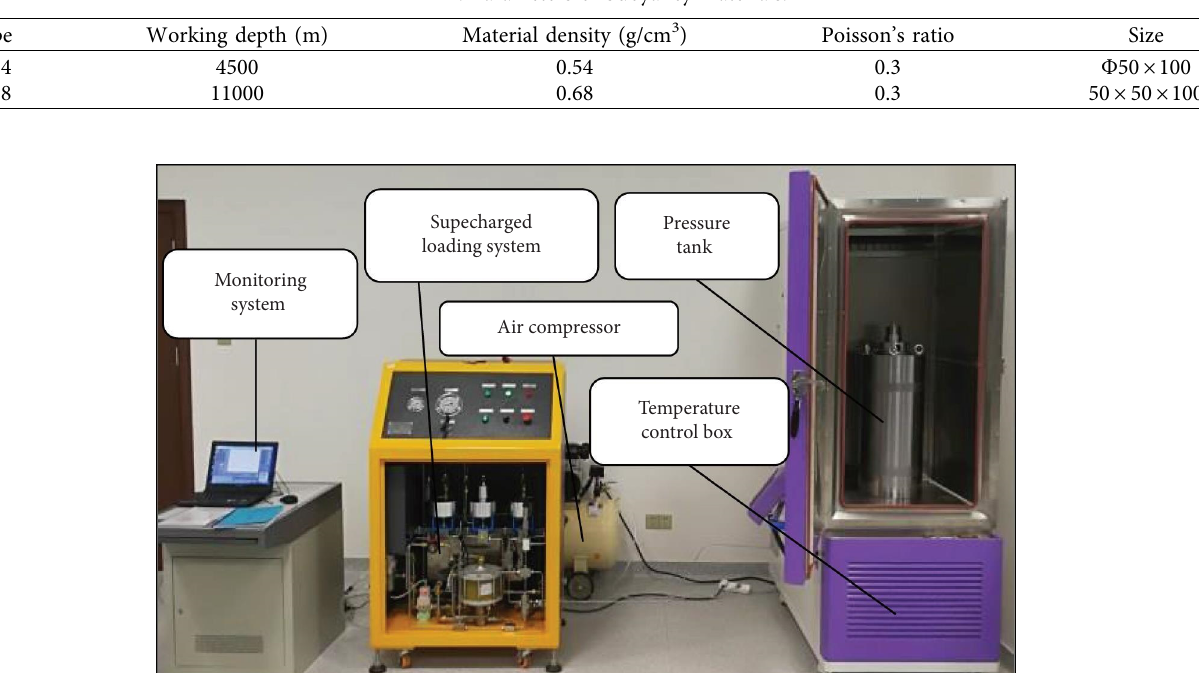
Figure 2: Controllable temperature isostatic pressure test